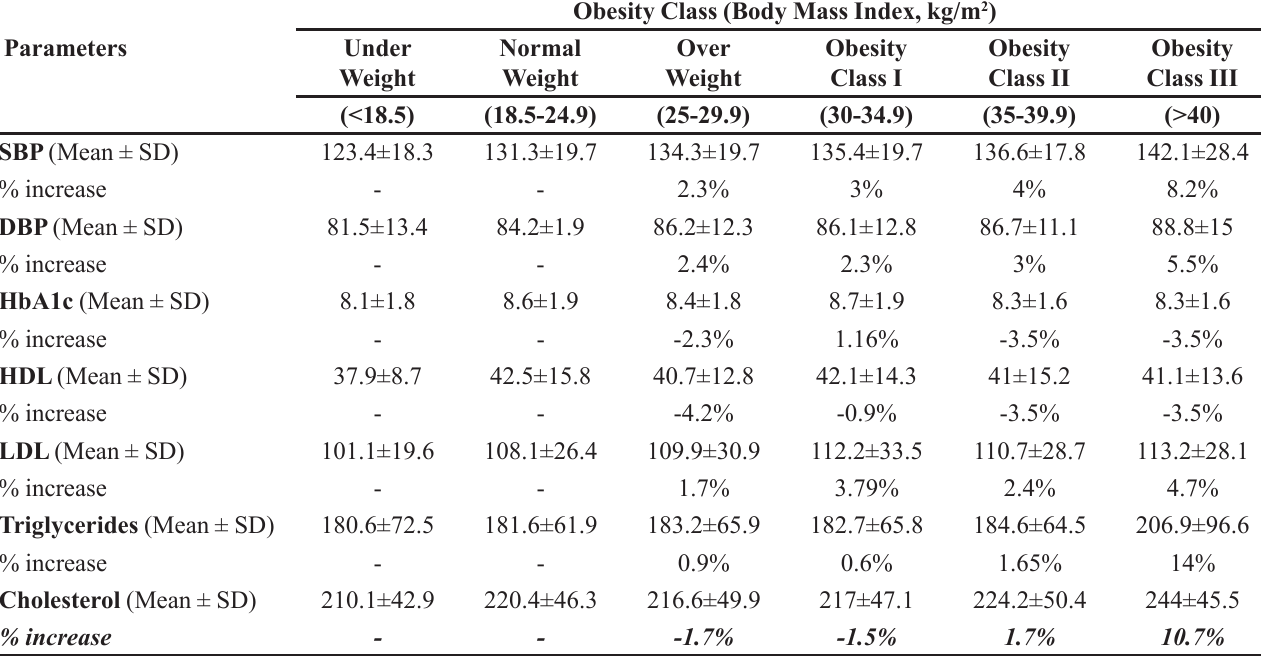
TABLE II - Blood pressure, HbA1c and lipid profiles as per body weight and obesity class